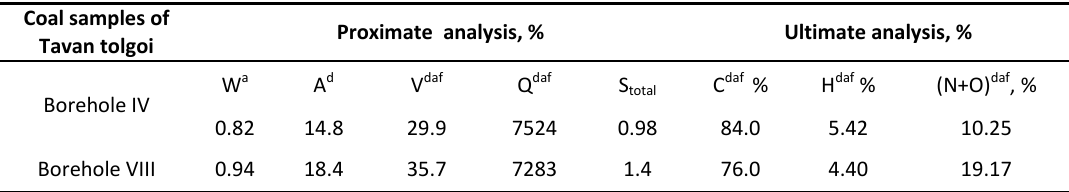
Table 2. Proximate and Ultimate analyses of Tavan tolgoi